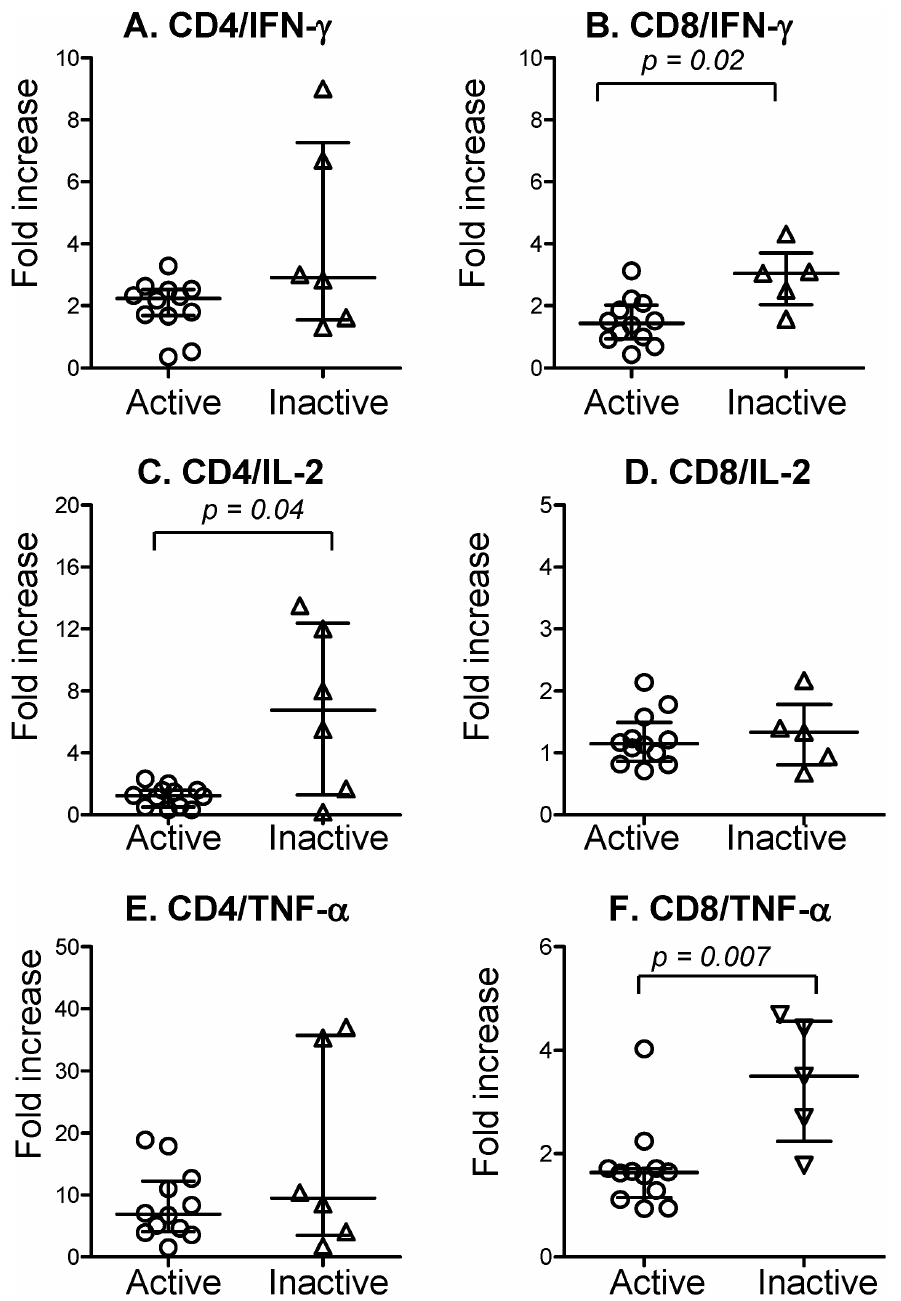
Figure 3. Comparison of cytokine production between active cases (circles) and inactive cases (triangles) with opportunistic infections. Solid lines show the medians with interquartile ranges of each group. Indicated p values for comparisons are by unpaired